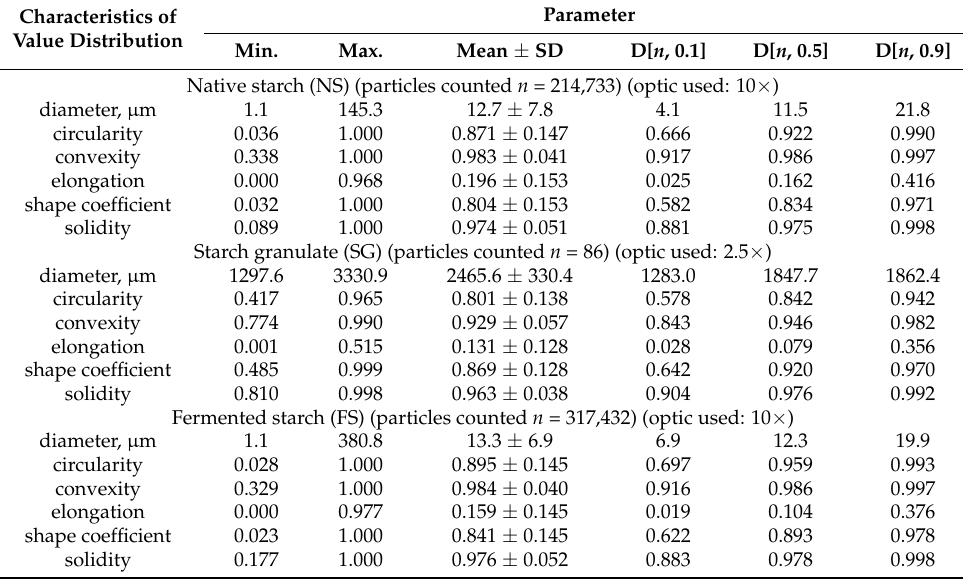
Table 1. Selected physical characteristics of the analyzed cassava starches. Characteristics of Value